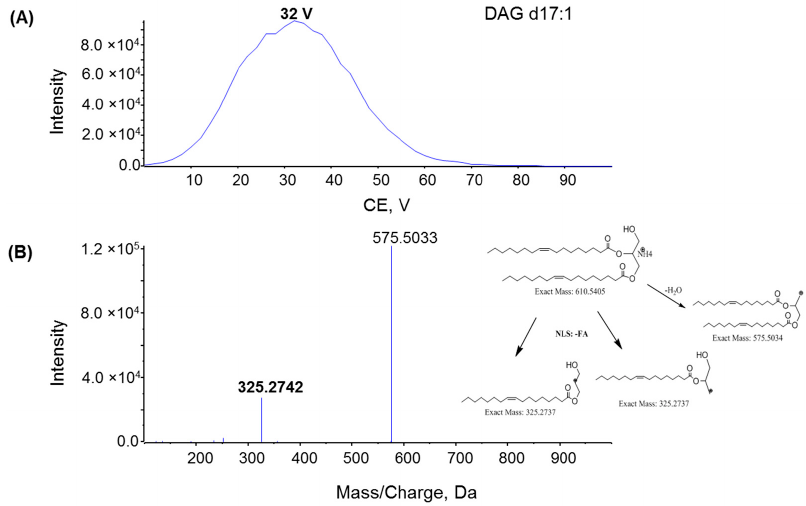
Figure 6. ( A ) Plot intensity of fragment m / z 325.2742 of DAG d17:1 with varying rolling collision energy (CE); ( B ) MS/MS spectra for DAG d17:1 with CE = 32 V; insert: the fragmentation